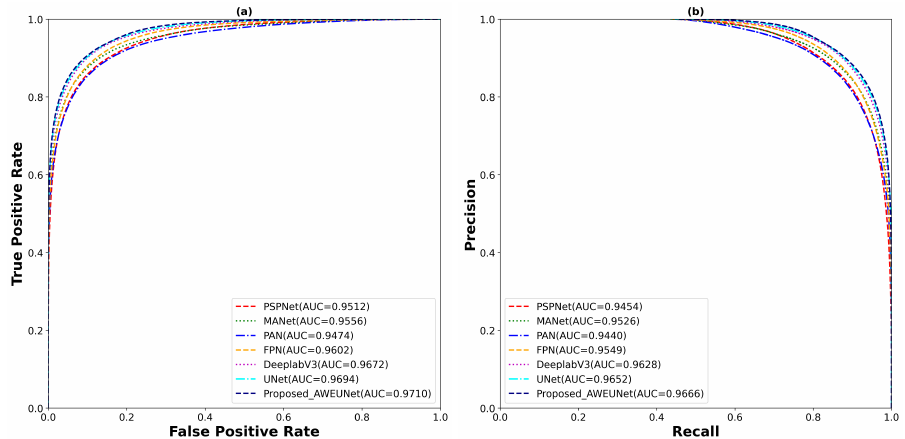
Figure 8. The ( a ) ROC and ( b ) PR curve for all test samples of the LUNA16 lung nodule segmenta- tion